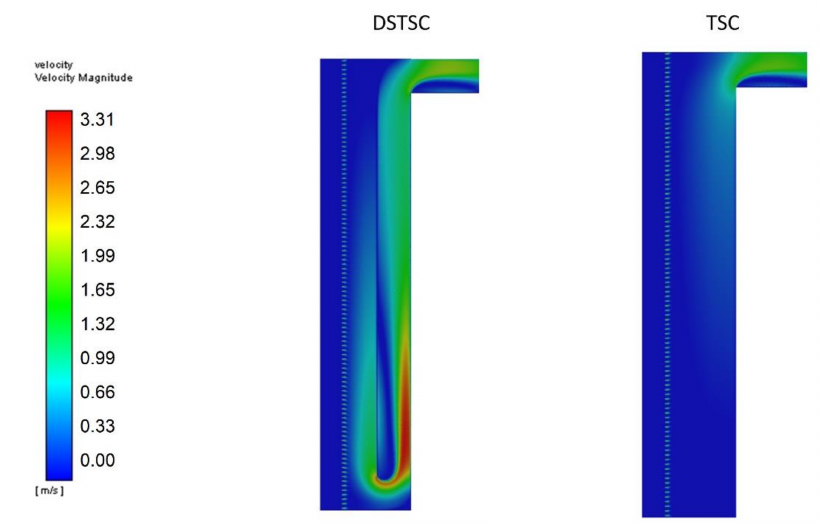
Figure 11. Velocity distribution in a median plane for the DSTSC ( left ) and TSC ( right ) at air flow of 500 m 3 /h.